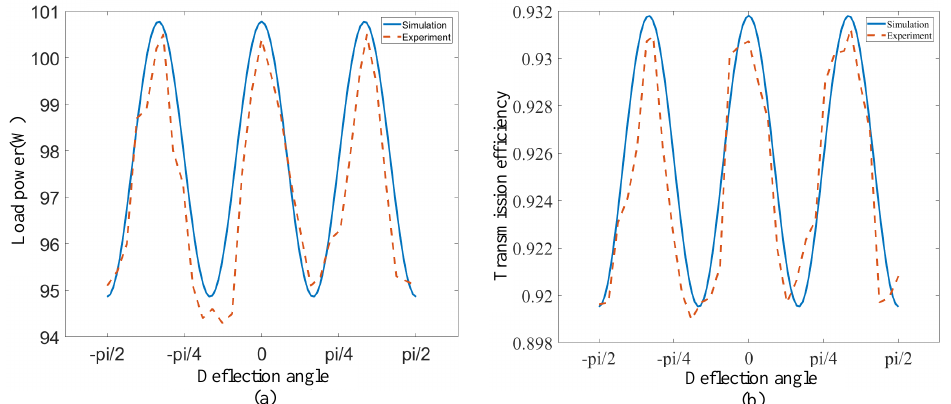
Figure 9. The transmission characteristics of receiver with three coils vary with deflection angle. The pitch rotation angle γ = 0, R = 10 cm, N = 11, d 1 = 15 cm, d 2 = 0. ( a ) shows the load power varies with deflection angle. ( b ) shows the efficiency varies with deflection angle. The simulation is completed by Matlab.